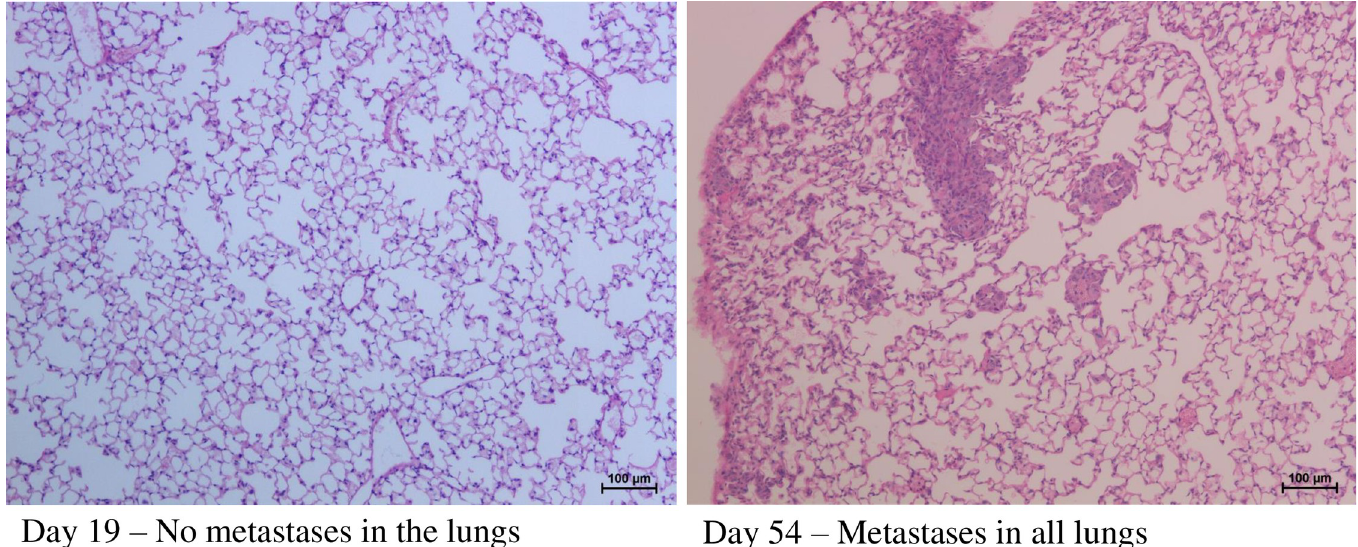
Fig 1. Lung morphology. 5 x10 5 cells were injected in the mammary fat pad in the groin area. No metastases to the lungs were present after 19 days, however all animals had developed metastases by day 54. Scale bar: 100 μ m.